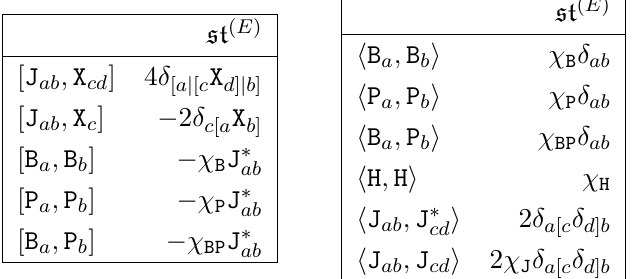
Table 8 . Double extension based on the static spacetimes in D + 1 dimensions and its invari- ant metric. The vector X a stands for B a , P a ; the tensor X ab for J ab , J (cid:3) nondegenerate if (cid:31) and ( (cid:31) (cid:31) (cid:0) (cid:31) 2 ) are H B P BP